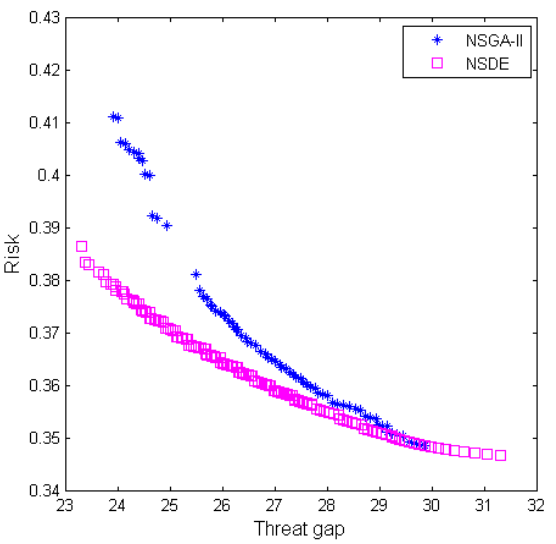
Figure 9. Pareto sets of two different algorithms.